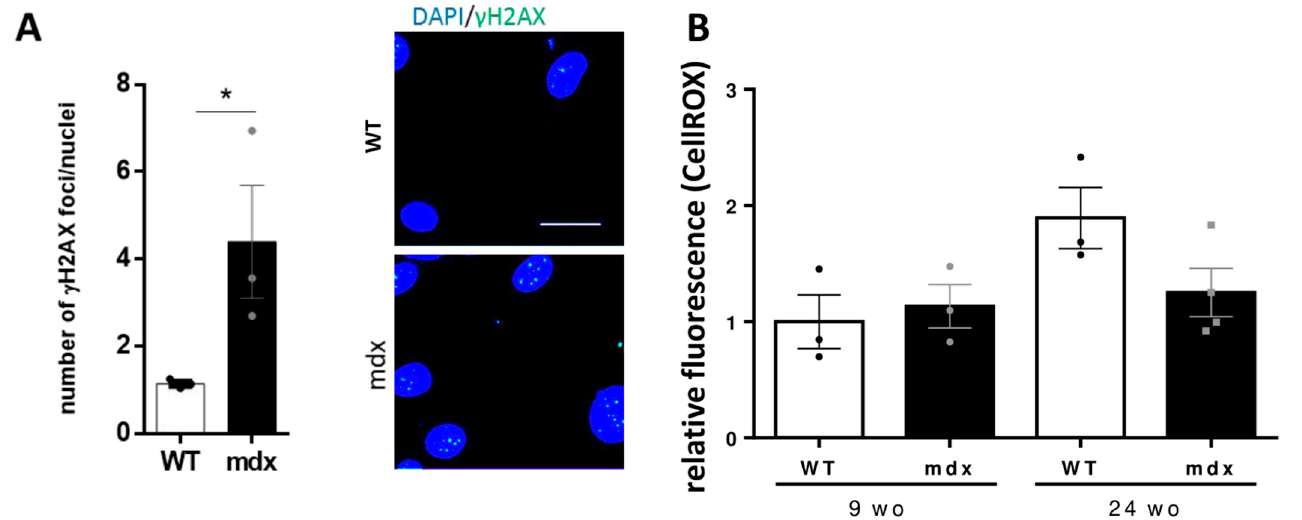
Figure 6. DNA damage is increased in mdx CVPCs. ( A ) Bar graphs showing the DNA double stranded breaks in isolated CVPCs from 24 wo WT and mdx mice as illustrated with the two images on the right. The DNA damage was evaluated as the ratio of γ H2AX foci number (in green) per total number of nuclei (DAPI labeled, in blue) per image. At least 20 cells were evaluated from each animal; the average from each animal was used for statistics with three animals per group (* p < 0.05). The scale bar represents 20 µ m. ( B ) Bar graphs showing the relative fluorescence of ROS production using CellROX dye on freshly isolated CVPCs of 9 and 24 wo mice. At least three animals per group were used. The values are represented in the bar graphs for WT (open bars and black circles/dots) and mdx (black bars and grey dots). The statistical difference was calculated using two ‐ way ANOVA.